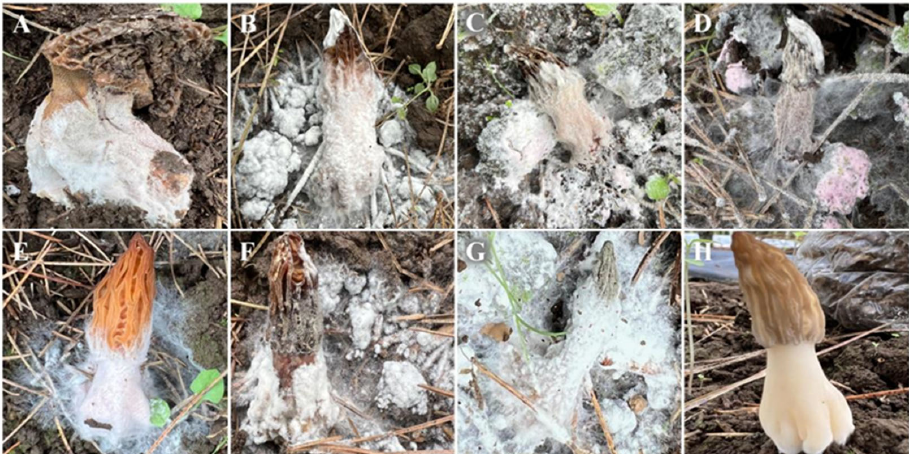
Figure 1. Field symptoms and pathogenicity of M. sextelata cobweb disease. ( A – D ) Field symptoms at different stages of the disease. A : initial disease symptoms; B , C : middle disease symptoms; D : late disease symptoms. ( E – H ) Pathogenicity test where a spore suspension with a concentration of 5 × 10 6 spores/mL was sprayed. E : The symptoms of M . sextelata fruiting bodies 7 days after inoculation; F : after 12 days of inoculation M. sextelata fruiting bodies stopped developing and suffered from soft rot; G : after 15 d of inoculation, the fruiting bodies collapsed and died; H : control, no disease symptoms appeared after 15 d of inoculation with sterile water.